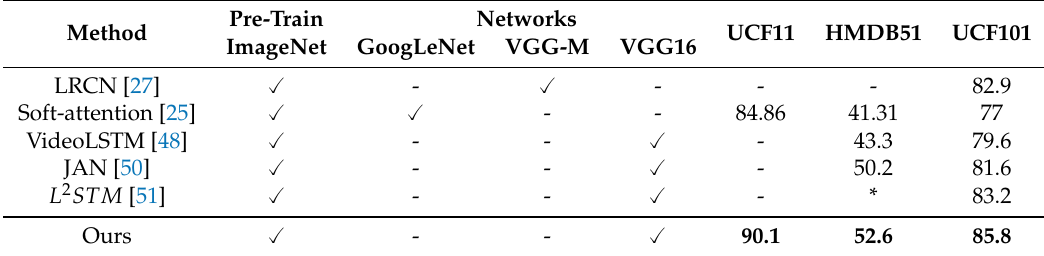
Table 3. State-of-the-art comparison with LSTM-like architectures. Classification accuracy is used as evaluation measure which represented as recognition accuracies (%). The bold text represents the best